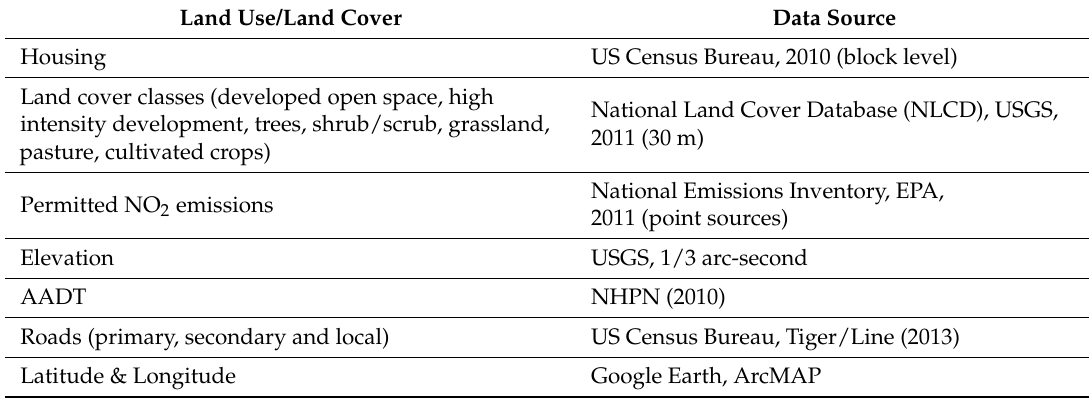
Table 1. Land use/land cover categories used in analysis, data source, and spatial resolution. Land Use/Land